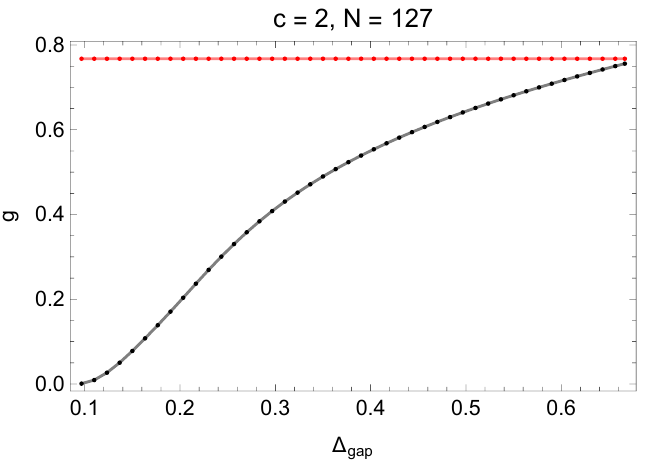
Figure 5. Upper (red) and lower (black) bounds on the g -function for stable boundary conditions in c = 2 CFTs as a function of the gap in the bulk scalar sector.